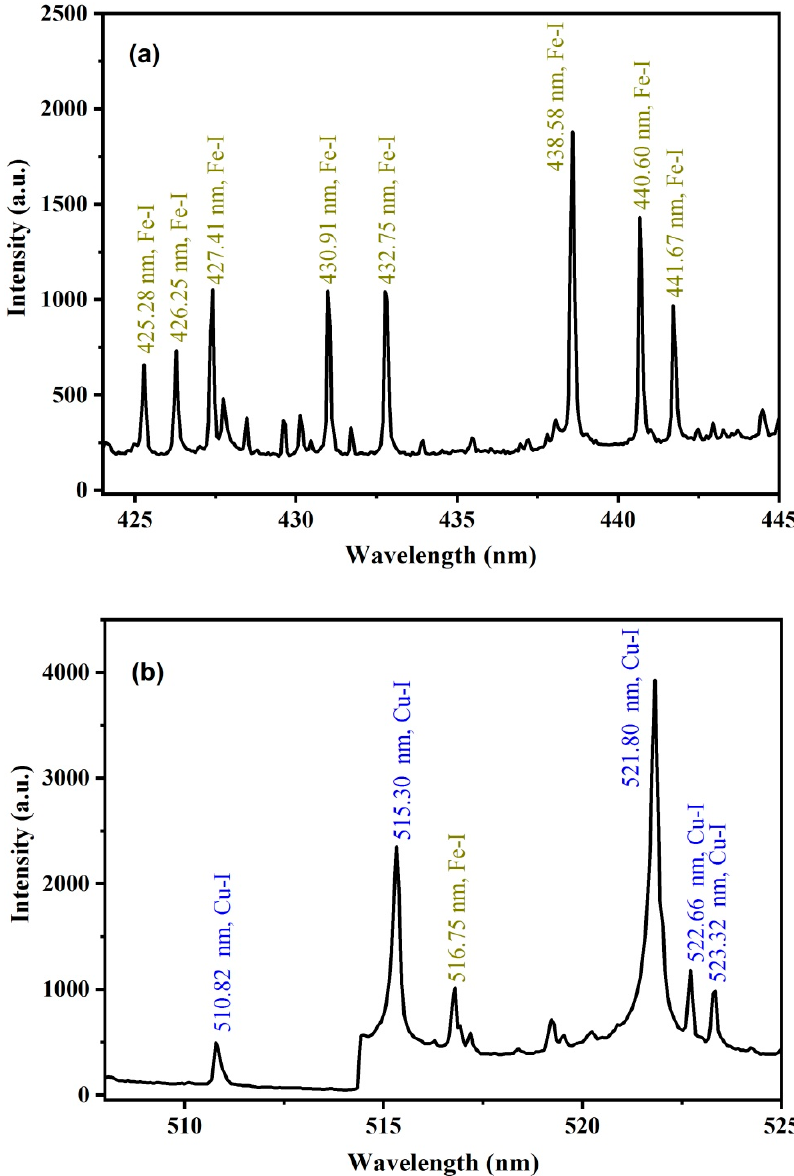
Figure 3. Optical emission spectra of chalcopyrite plasma in the range of ( a ) 425–445 nm and ( b ) 510–525 nm containing the signature lines of Fe and Cu respectively. Table 1. Identified spectral lines of different elements in emission spectrum of chalcopyrite.